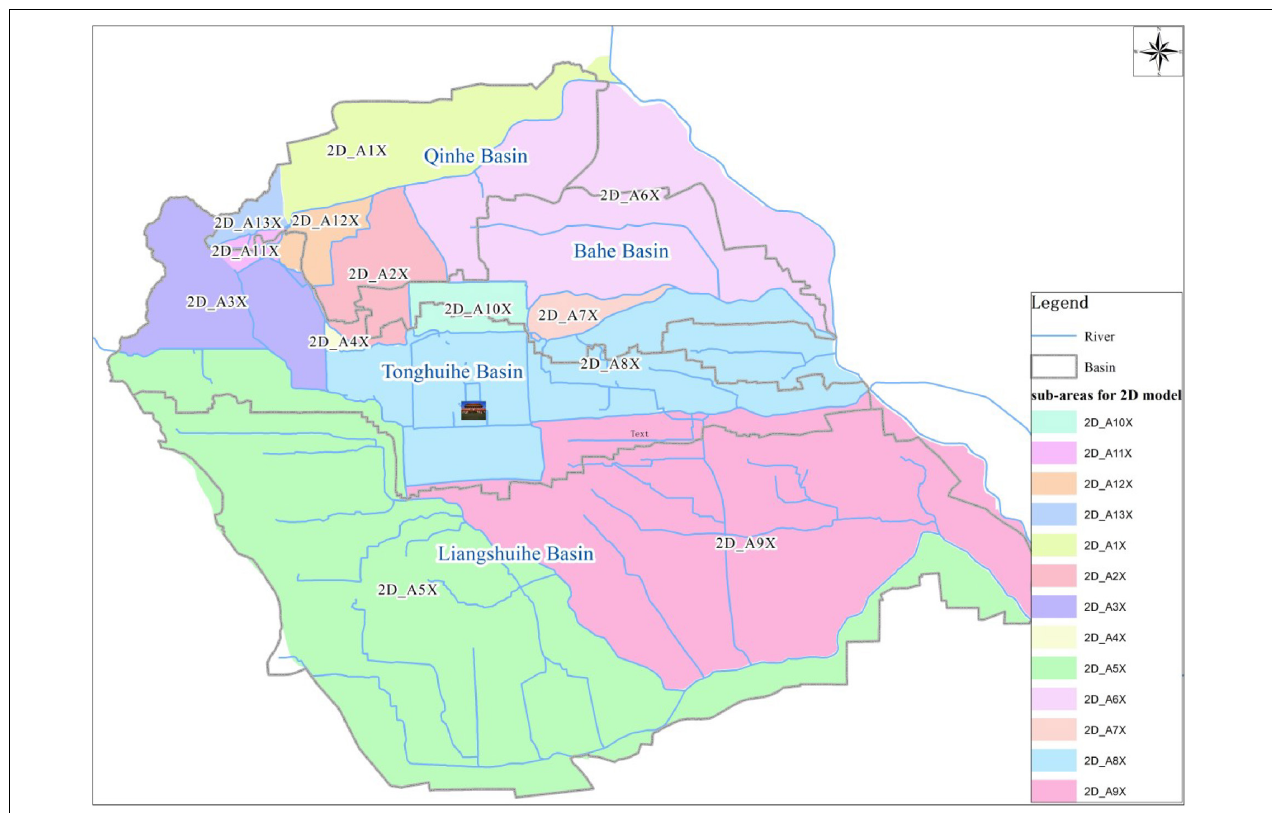
FIGURE 1 | The four river basins of Beijing